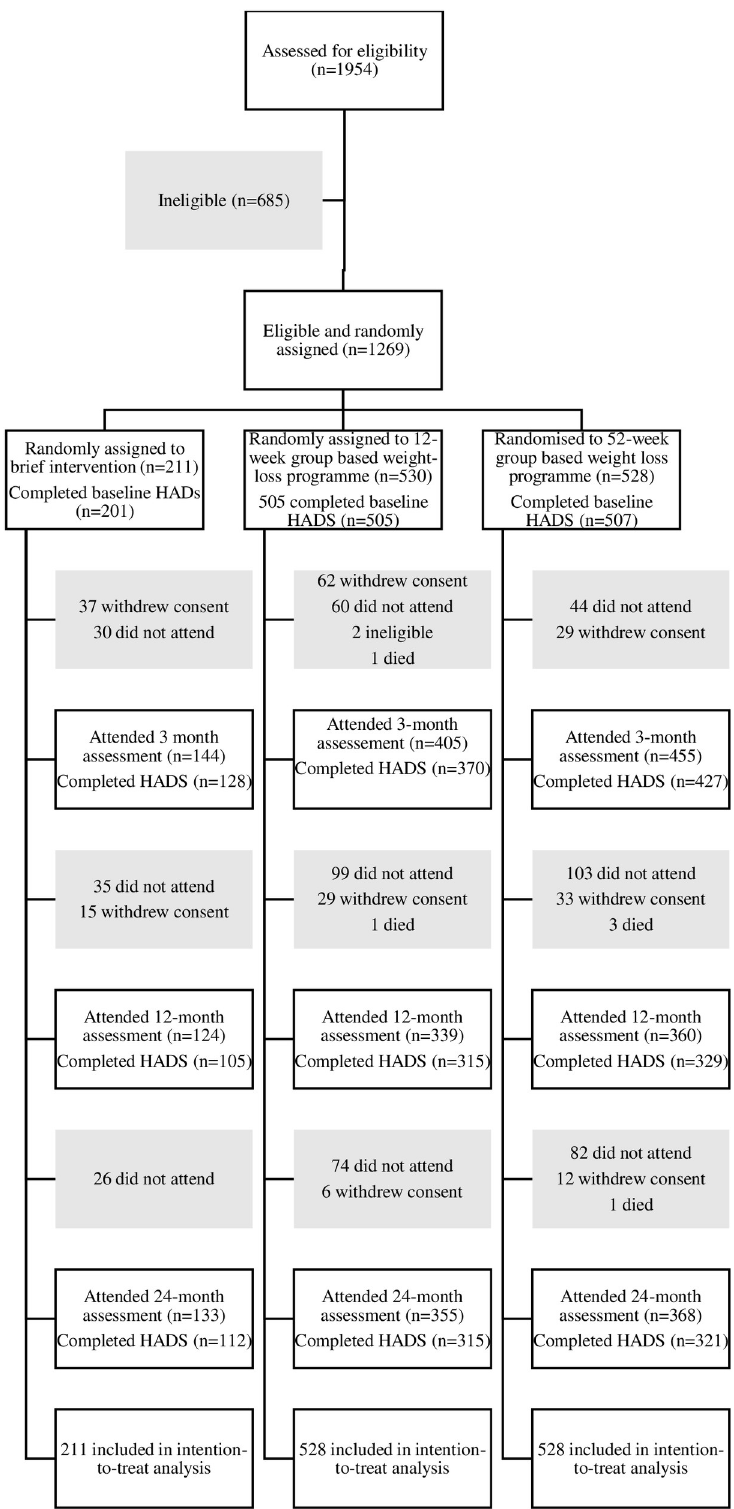
Fig 1. CONSORT flow diagram for trial participants recruited between October 18, 2012 and February 10, 2014.